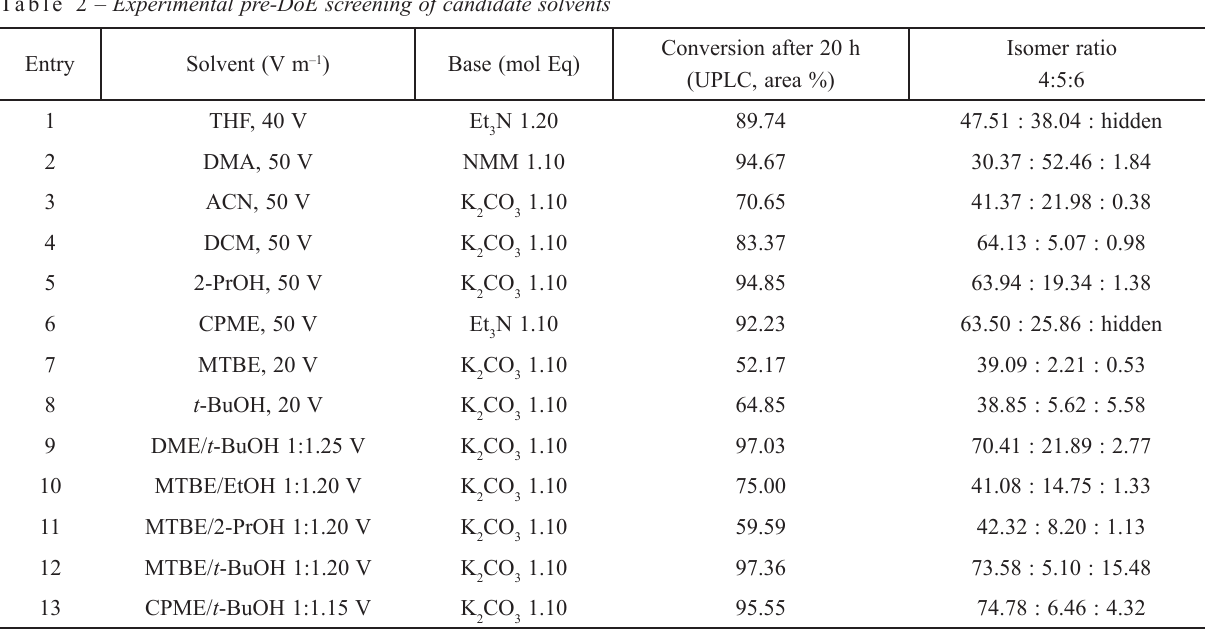
Table 3 – Experimental pre-DoE screening of bases (solvent cPME/t-BuoH, 50 V m –1 , ZnCl Entry Base (mol